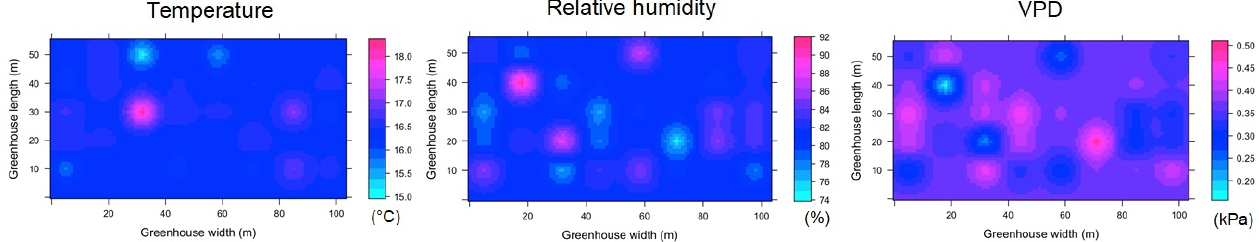
Figure A1. Spatial distribution predicted by kriging, for temperature, relative humidity and VPD in MG and for ESRL 2.